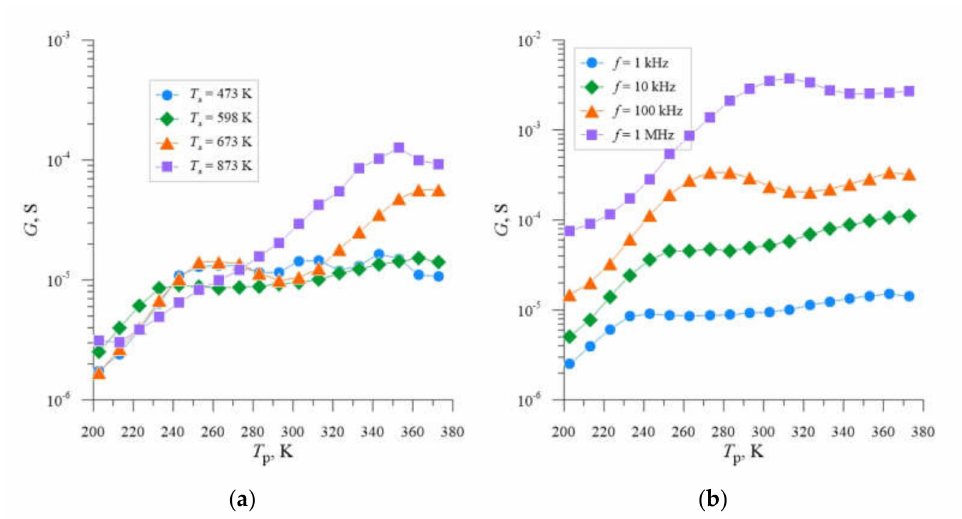
Figure 3. Dependencies G = f( T p ) for silicon with resistivity ρ = 0.4 Ω cm, boron-doped, implanted with Ne + neon ions with energy E = 100 keV and dose D = 4.0 × 10 13 cm − 2 , determined for the frequency f = 1 kHz and four different annealing temperatures T a ( a ) and annealing temperature T a = 598 K and four different measurement frequencies f ( b ).